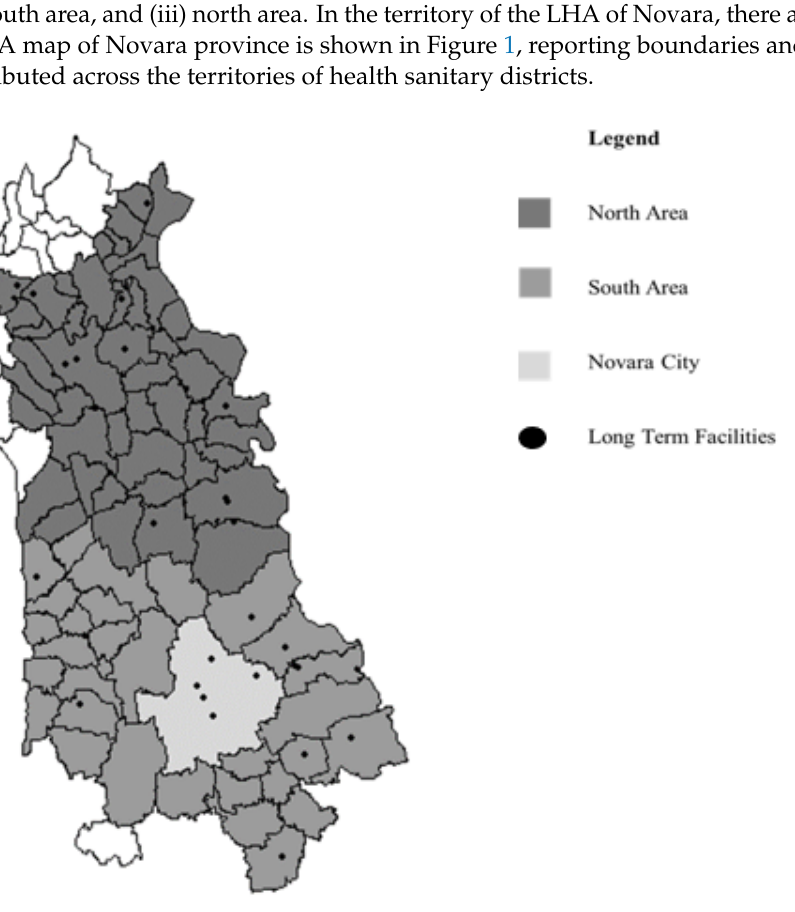
Figure 1. Map of Novara LHA. Colors represent the health sanitary districts, while long-term facilities are reported as black dots.